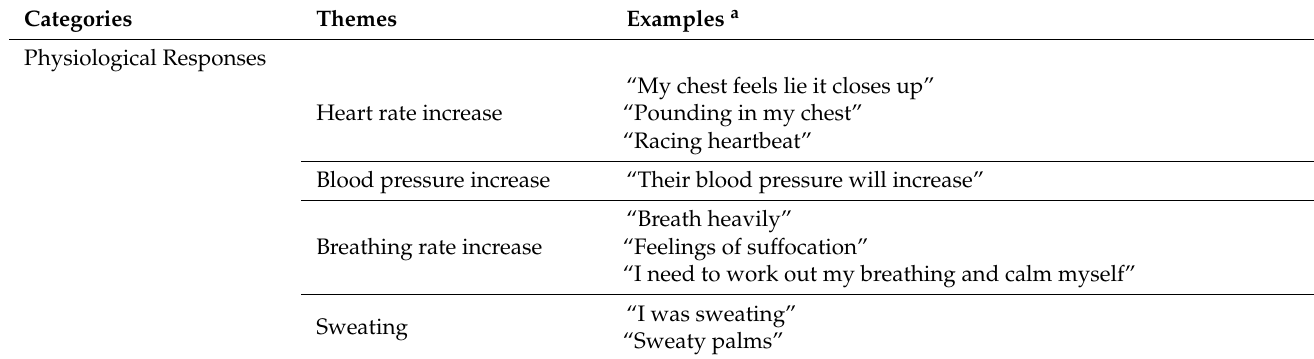
Table 5. Summary of symptoms of dental fear, dental anxiety, and dental phobia mentioned in the